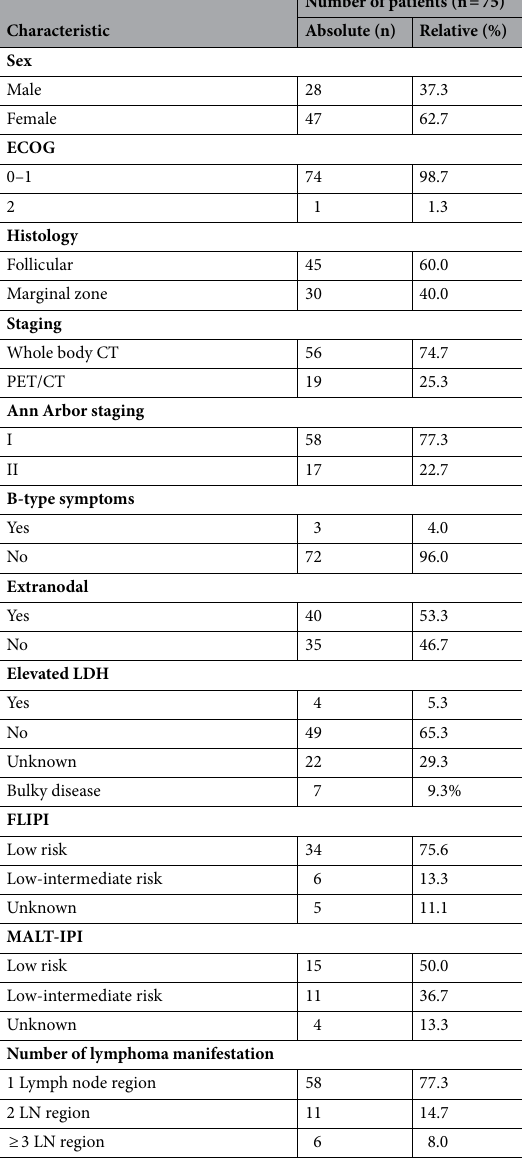
Table 1. Patients’ characteristics. FLIPI Follicular Lymphoma International Prognostic Index, MALT-IPI Marginal Zone Lymphoma International Prognostic